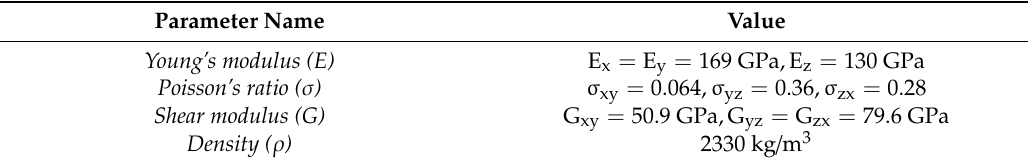
Table 2. Specific parameters of silicon.